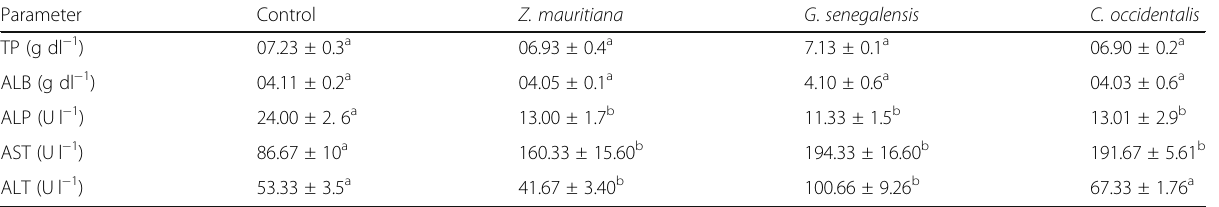
Table 4 Liver enzymes of the rats dosed with Z. mauritiana , C. occidentalis , and G. senegalensis Parameter